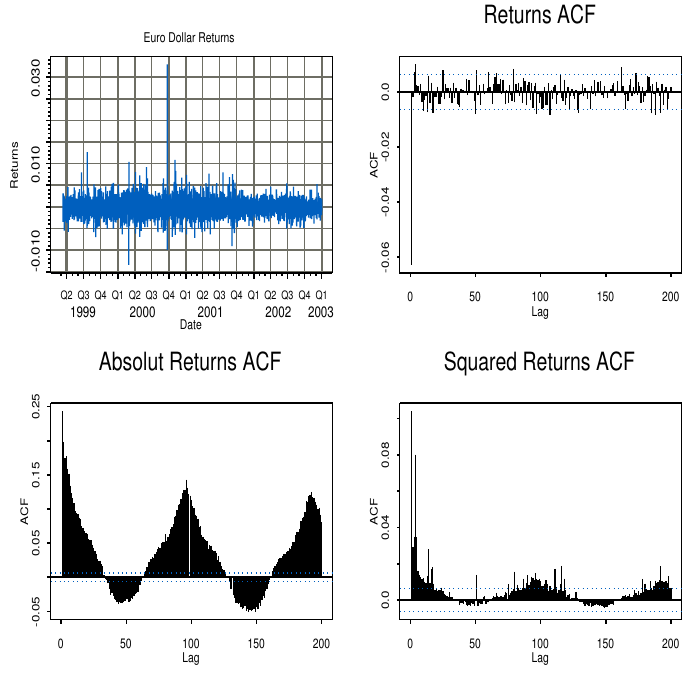
Figure 2. Euro-Dollar returns: acf of returns, acf of absolute returns and acf of squared returns. The seasonally adjusted returns are then given